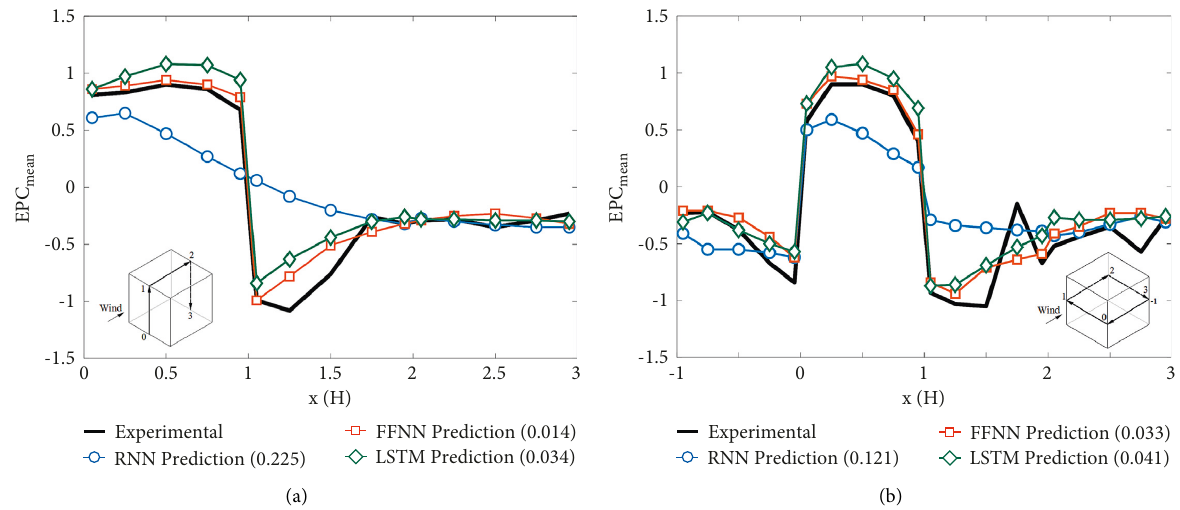
Figure 10: Comparison of the experimental EPC �− 10 ° : (a) along the longitudinal mean and those predicted by the trained ANN models for θ center line; (b) along the transverse center line. Numbers inside brackets indicate the MSE values.